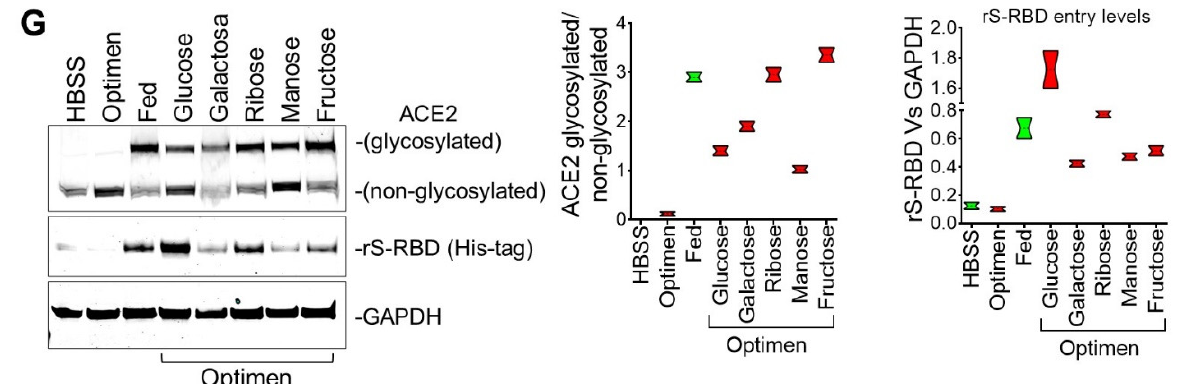
Figure 1. Molecular bases of glycosylated hACE2 and SARS-CoV-2 Spike protein complex. ( A ) 3D membrane surface representation of glycosylated ACE2 in complex with the SARS-CoV-2 Spike protein. ( B ) Close up of the interacting environment between ACE2 and the S-RBD trimer. ( C ) The left panel demonstrates glycan–glycan interactions between ACE2 (dark purple surface) and S-RBDc (light purple surface). The right panel shows that glycan–glycan contacts do not affect their molecular electrostatic potentials (MEPs) properties. The energy scale ranges from − 0.075 µ a (red) to 0.075 µ a (blue). ( D ) ACE2 glycan at N53 forms glycan–protein contact with residues on the S-RBDa and S-RBDc proteins. ( E ) The ACE2 glycosylation induces the formation of hydrogen bonds that engages the helix α 1 in the binding with multiple residues on the S-RBDc. ( F ) Hydrophobic interactions occur between ACE2 at T334 and multiple residues on the S-RBDc. ( G ) Immunoblot shows the glycosylation status of the human ACE2 in HUVECs treated with different saccharides. Glucose-treated cells induced the greatest internalization of the recombinant S-RBD. Quantification of protein levels of three replicate experiments is shown. Student’s T -test, 2 tails. Bar graphs are presented as mean with error bars (±SD).